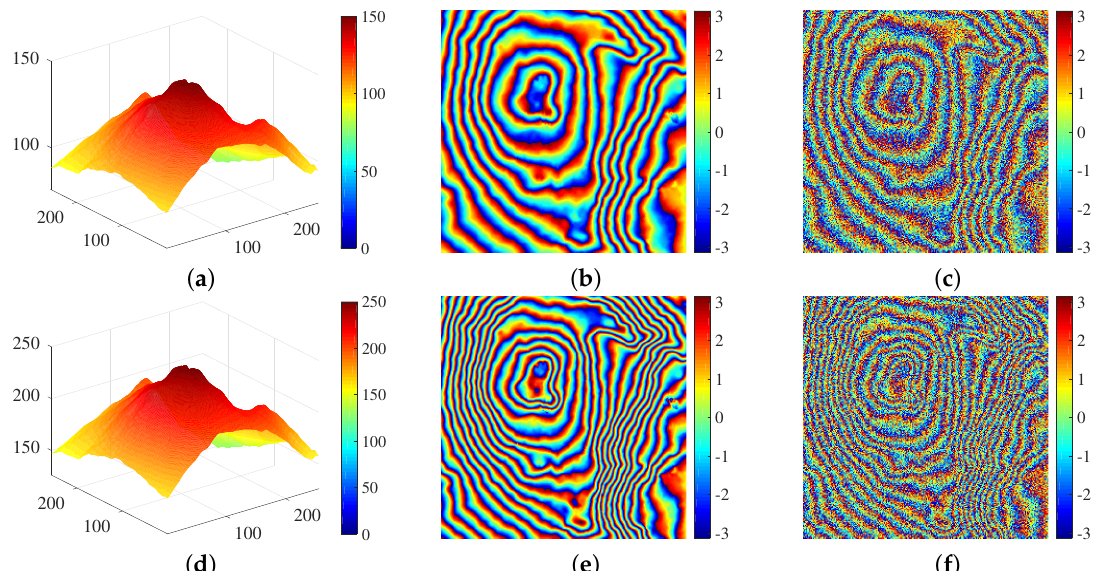
Figure 4. Two examples of using DEMs to generate samples. ( a ) Unwrapped phase (maximum is 150). ( b , c ) are the corresponding clean interferometric phase and noisy interferometric phase, respectively. ( d ) Unwrapped phase (maximum is 250). ( e , f ) are the corresponding clean interferometric phase and noisy interferometric phase,